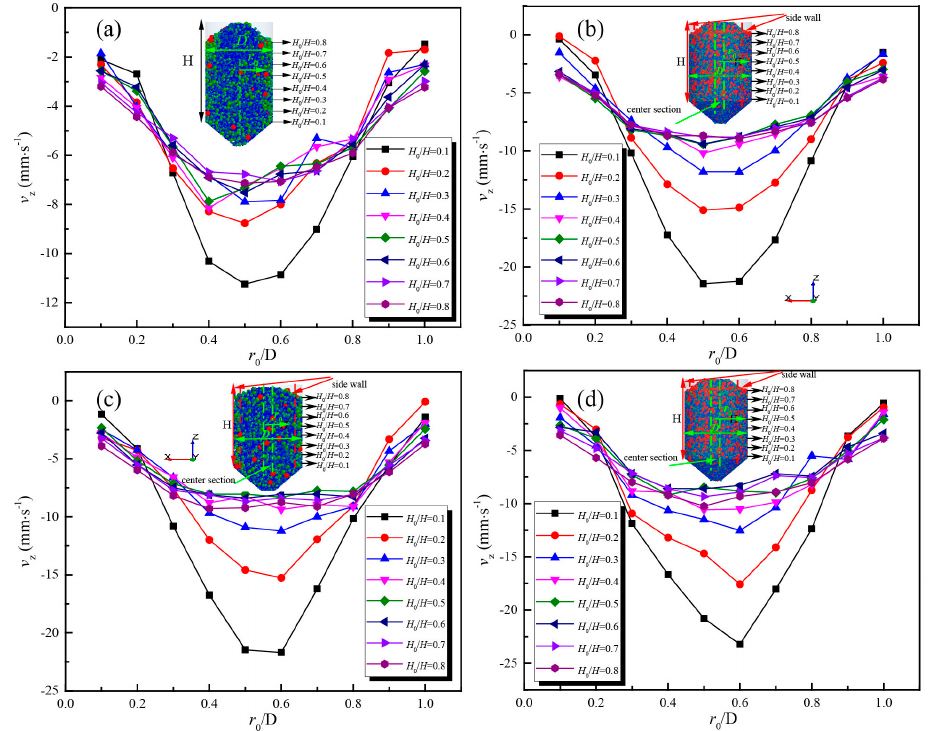
Figure 22. The variation in the velocity profile with sinter layers for different geometry factors of ( a ) D 0 / d p = 75, ( b ) D 0 / d p = 100, ( c ) D 0 / d p = 125, and ( d ) D 0 / d p = 150.